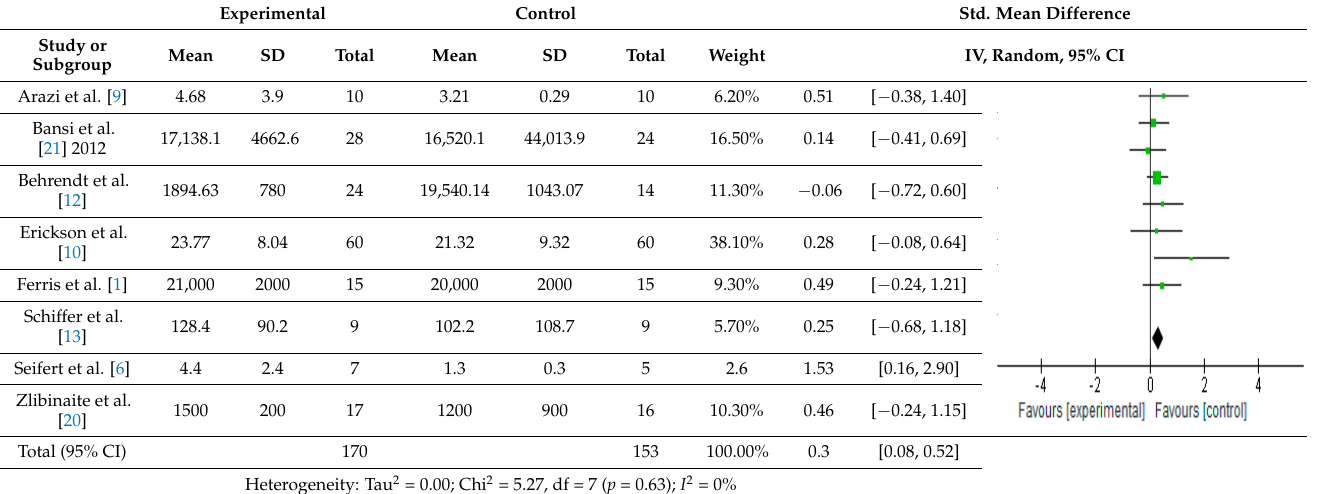
Table 3. Standardized mean differences and forest plot of comparison of endurance exercise group and control group on BDNF.